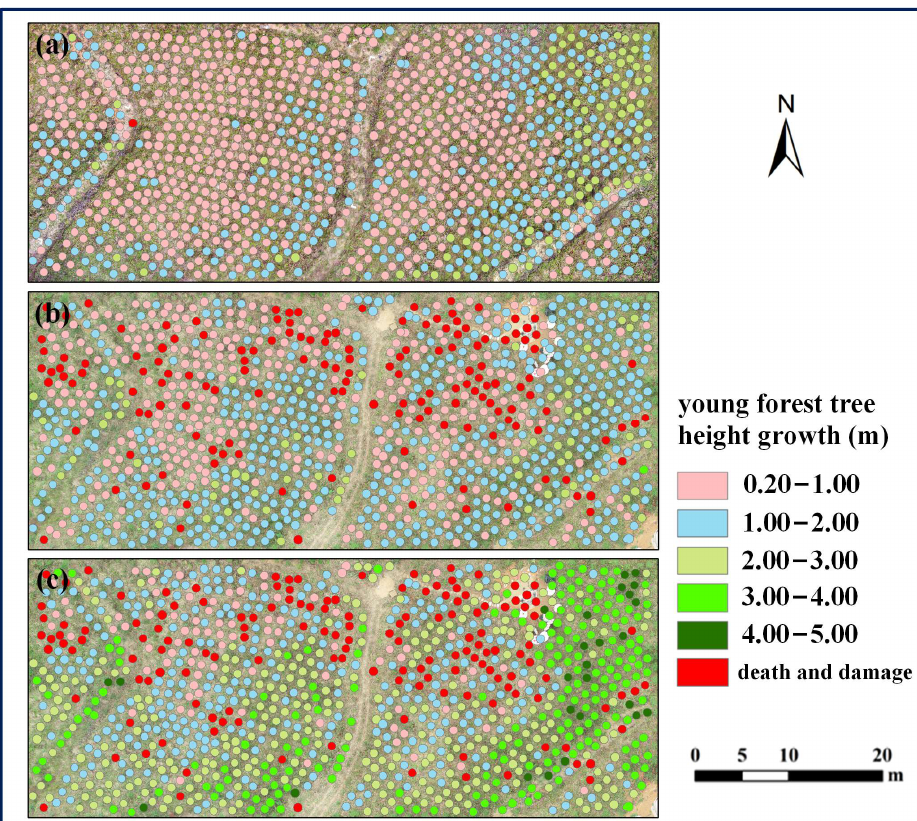
Figure 15. Dynamic change of tree growth. ( a – c ) show changes in young forest height growth at June 2019 to October 2021. The color indicates an additional amount of growth. The pink growth range is 0.2–1.0 m; the blue growth range is 1.0–2.0 m; the light green growth range of 2.0–3.0 m; the green growth range is 3.0–4.0 m; the dark green grows in the 4.0–5.0 m range. According to ( c ), the growth of 0.2–1.0 m in three years is poor; 1.0–2.0 m growth medium; 2.0–4.0 m is healthy growth; above 4.0 m is considered very healthy.